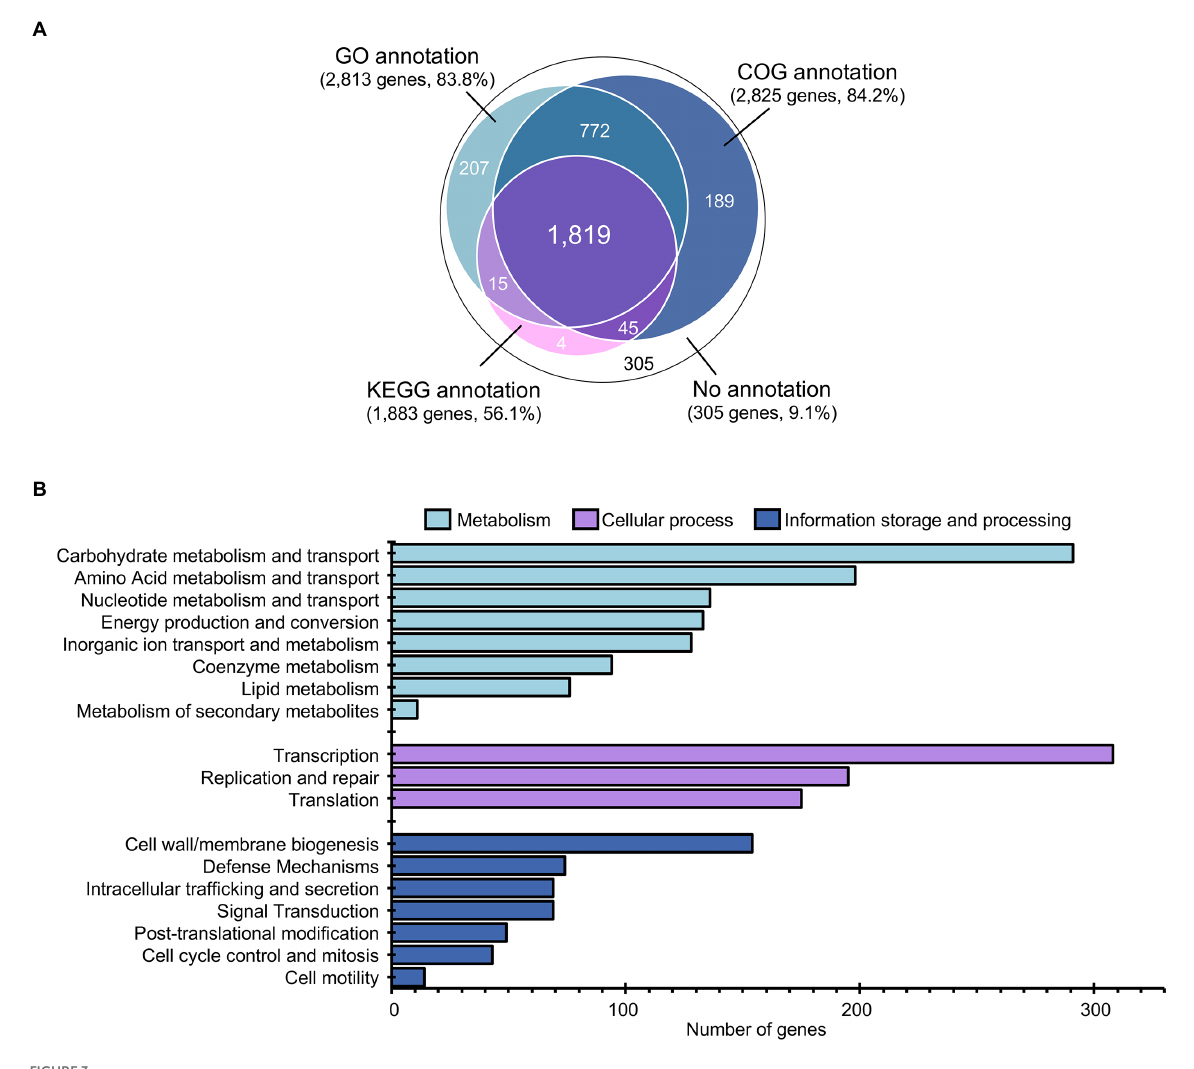
FIGURE 3 Annotation and gene function analysis of L. pentosus 9D3 genome. (A) Numbers of annotated genes from different databases. (B) Distribution of annotated genes across the different COG functional